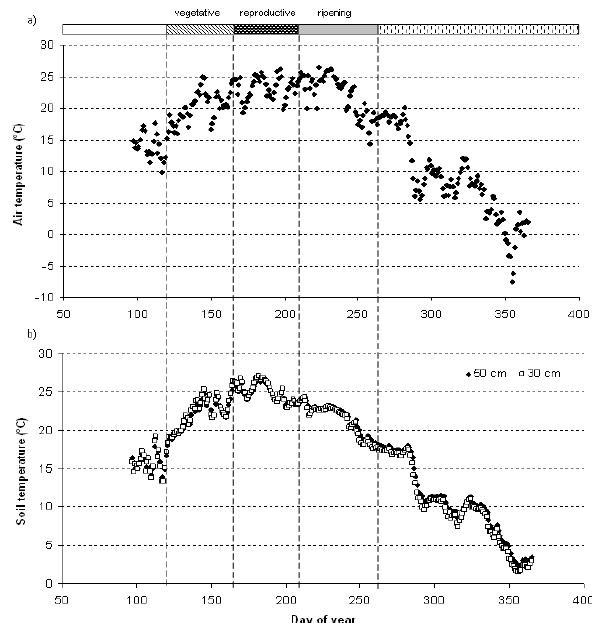
Fig. 2. Daily average soil water content at 0–15cm and 15–35cm (a) and depth of the water table (b) . Positive values indicate that the water table was above the soil